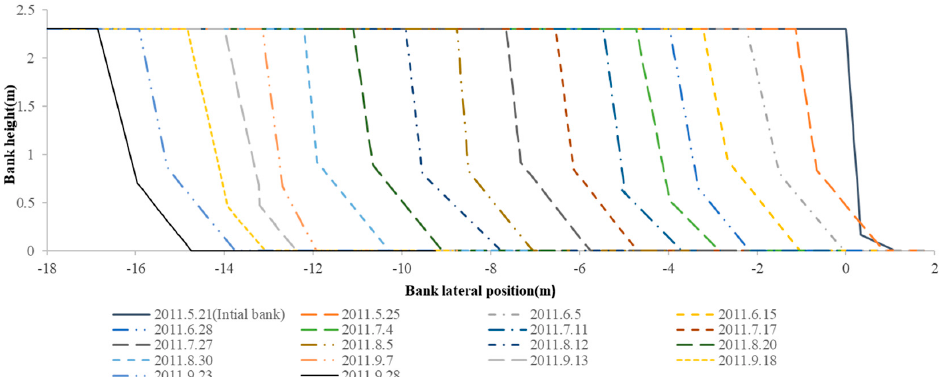
Water 2018 , 10 , x FOR PEER REVIEW Figure 7. Collapse phases for Section 2. Figure 7. Collapse phases for Section 2.